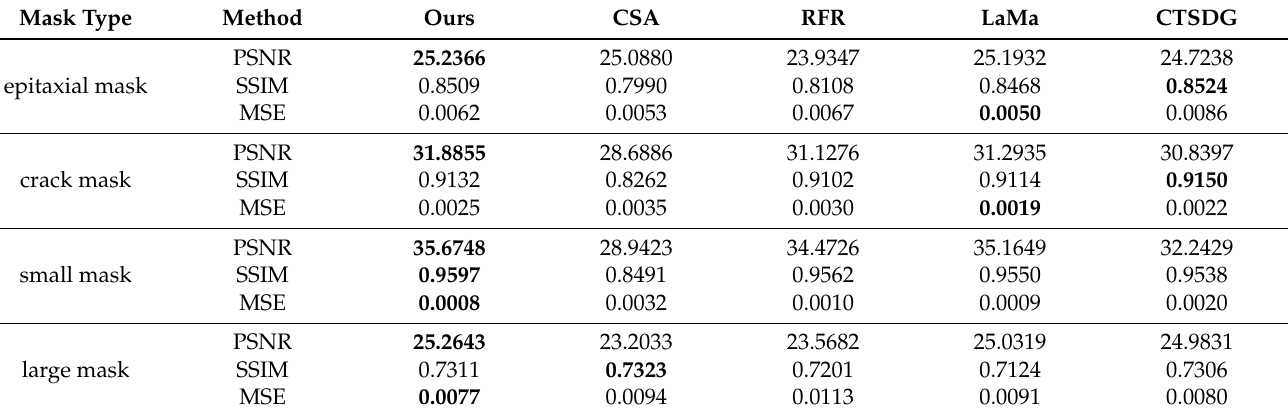
Table 4. Comparative experimental test indicators for each